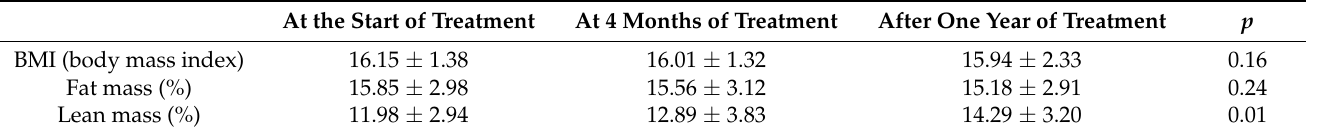
Table 6. Anthropometric assessment at the start, after 4 months and after one year.